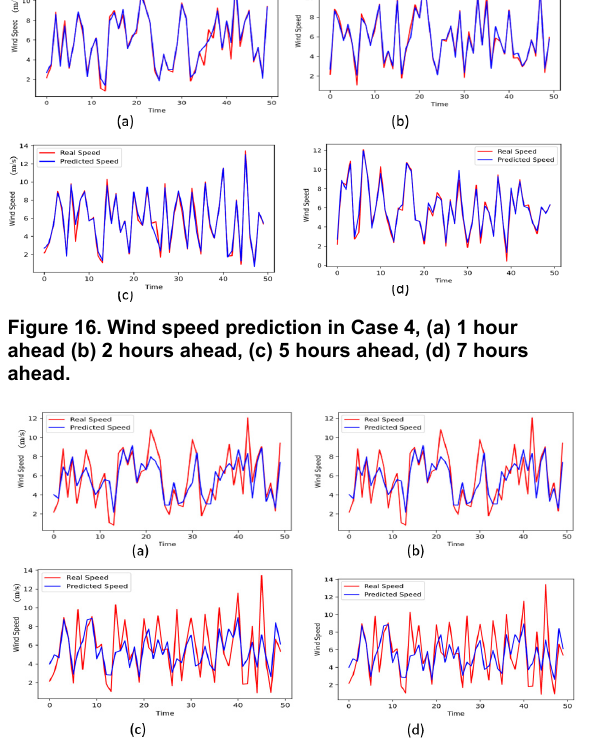
Figure 17. Wind speed prediction in Case 5, (a) 1 hour ahead (b) 2 hours ahead, (c) 5 hours ahead, (d) 7 hours ahead.